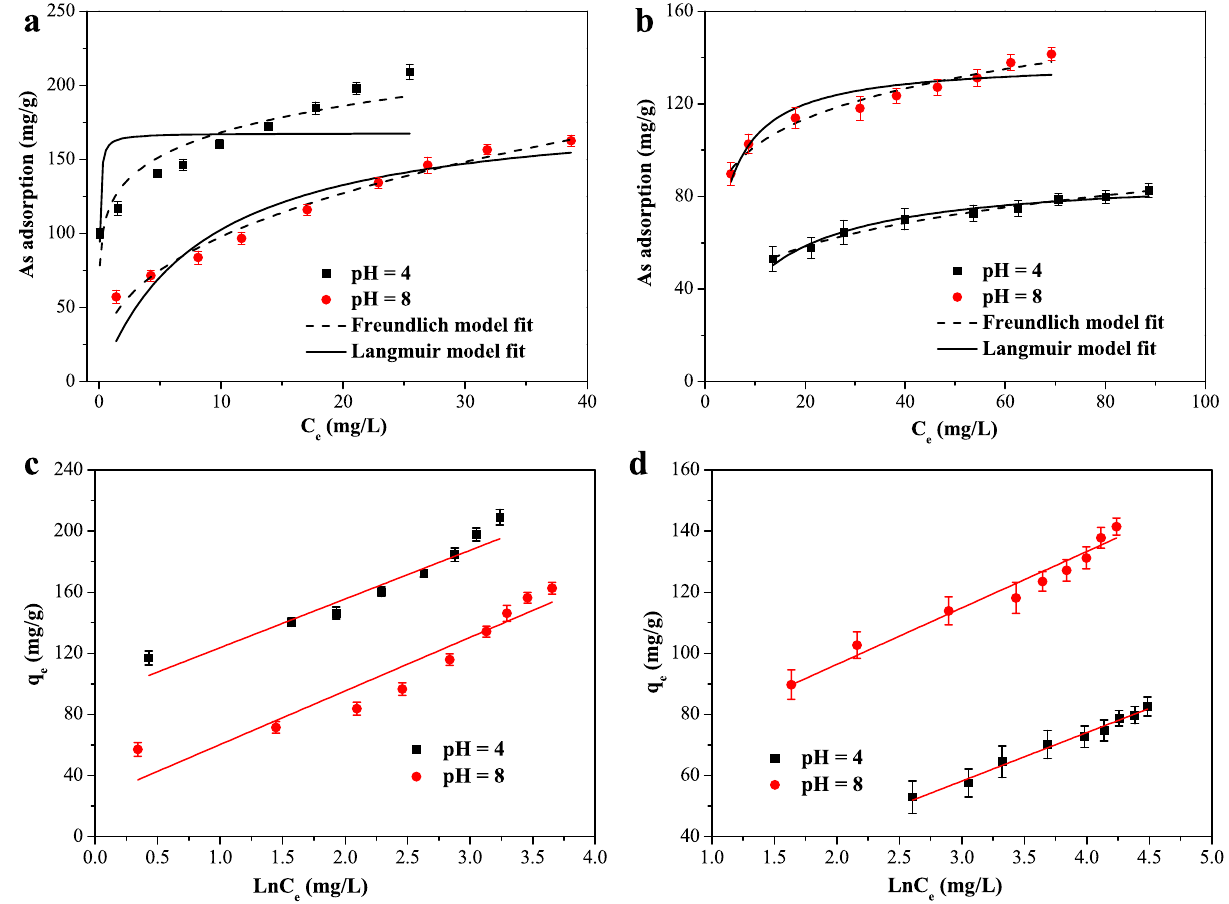
Figure 4. Adsorption isotherms of As(V) ( a ) and As(III) ( b ) adsorption at pH 4.0 and 8.0 with initial As concentrations ranging from 30 to 140 mg/L and dosage of 0.5 g/L. Temkin adsorption isotherm models of As(V) ( c ) and As(III) ( d ).